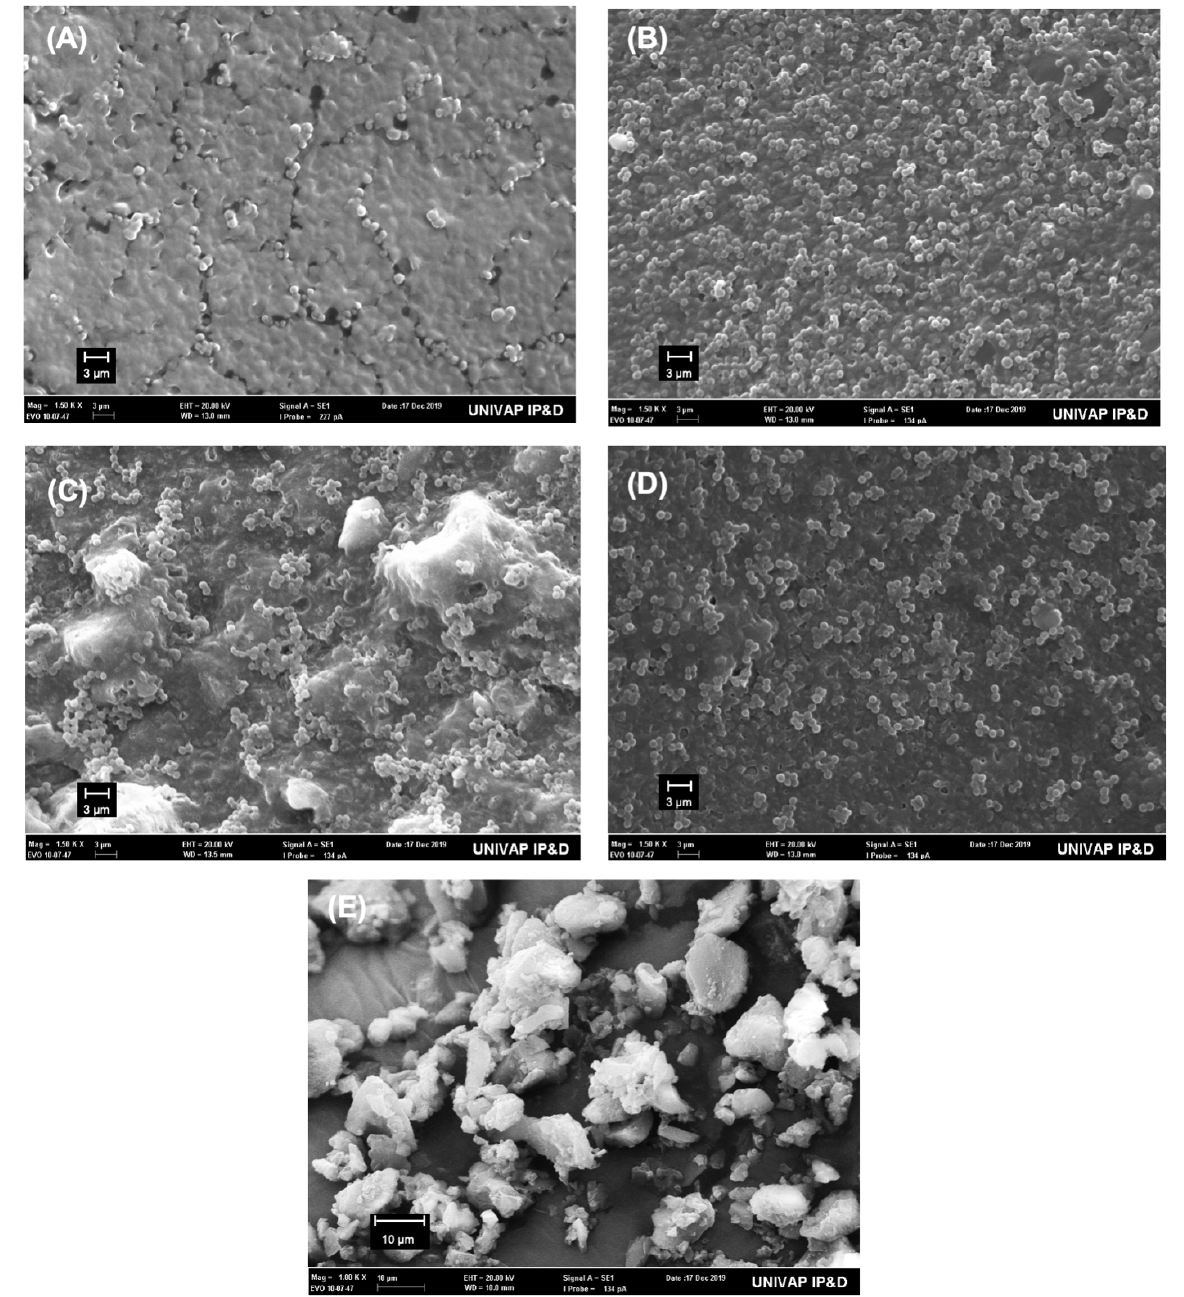
Figure 1. Representative SEM images of surface texture of resin polymerized disks from different groups and nisin particles. ( A ) control adhesive (without nisin); ( B ) nisin-doped adhesive with 1 wt% nisin; ( C ) nisin- doped adhesive with 3 wt% nisin; ( D ) nisin-doped adhesive with 5 wt% nisin. The CFU counts of S. mutans was roughly inversely proportional to the nisin concentration within the polymerized adhesive discs. ( E ) high magnification of the nisin particle, as we can see particle size is around 2 μ m, however clusters can be larger.